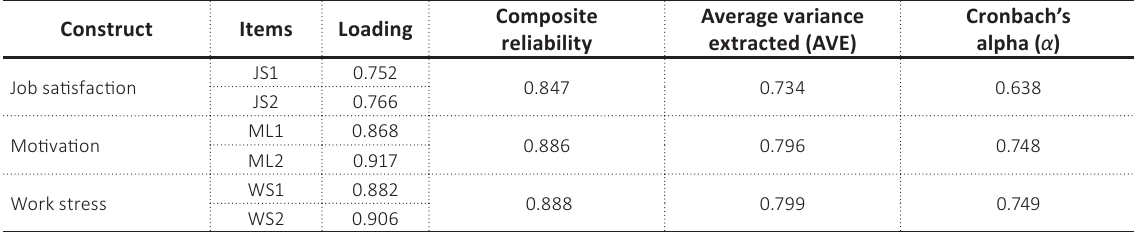
Table 3. Factor loadings, construct reliability, and validity